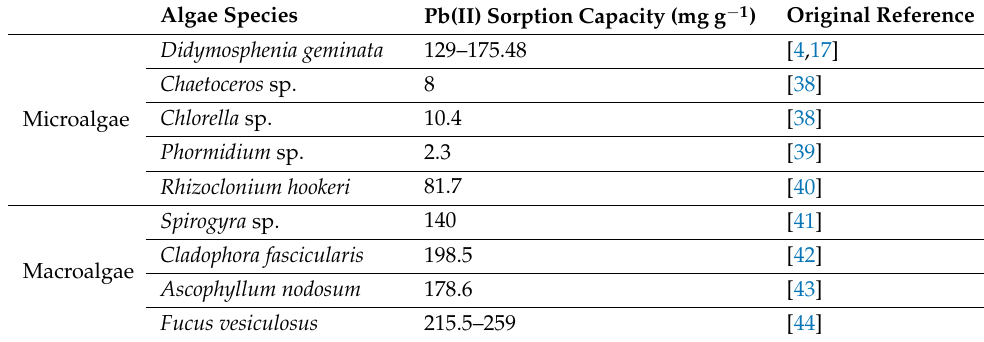
Table 2. Pb(II)-sorption capacities for various micro- and macroalgae species. Algae